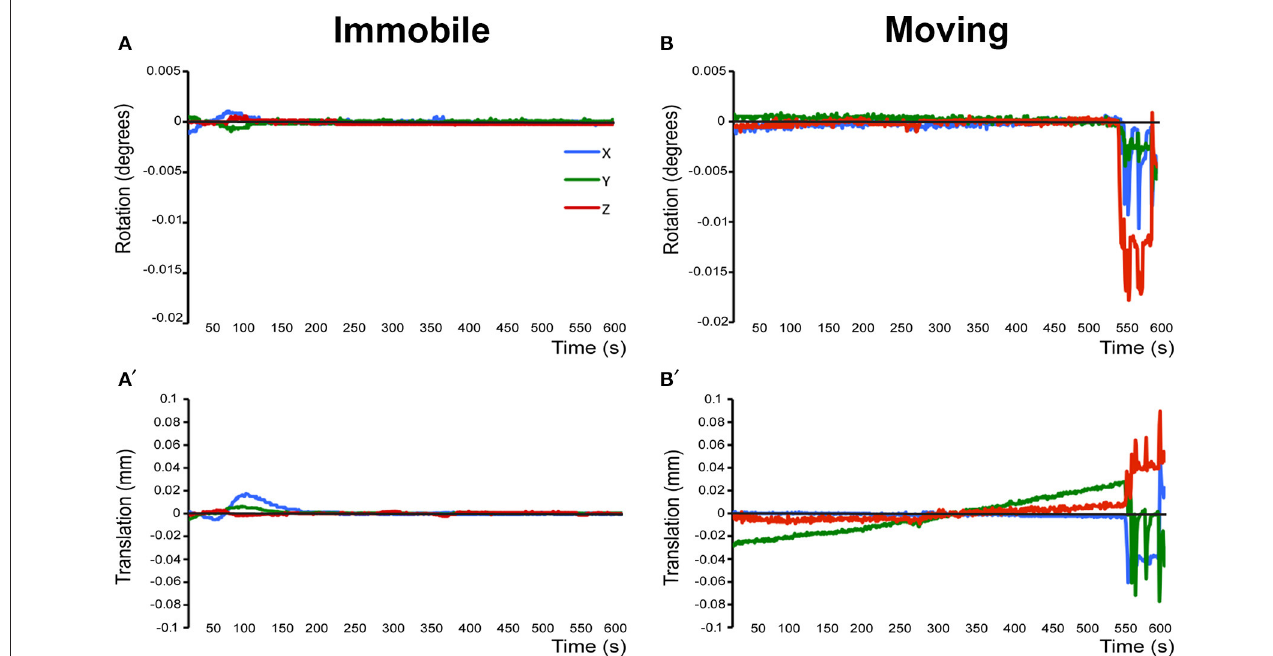
FIGURE 3 | Assessment of motion in lightly anesthetized infant rats during imaging. (A,A’) display the rotation (in degrees) and translation (in mm) for an immobile 2-week-old rat during MRI, respectively. Rotation is a rigid body movement and refers to the movement of the head around a center point. Translation is every point on the head moving a constant distance in a specific direction. The immobile rat’s head did not rotate more than 0.005 degrees or moved more than 0.02mm. This is an acceptable amount of movement for the group ICA. (B,B’) illustrate rotation and translation of an infant rat that moved during the scanning, which lead to a motion-related imaging artifact. As a result, data obtained from this animal was excluded from the group ICA. Blue X line, horizontal axis; Green Y line, vertical axis; Red Z line, longitudinal axis of the scanner.